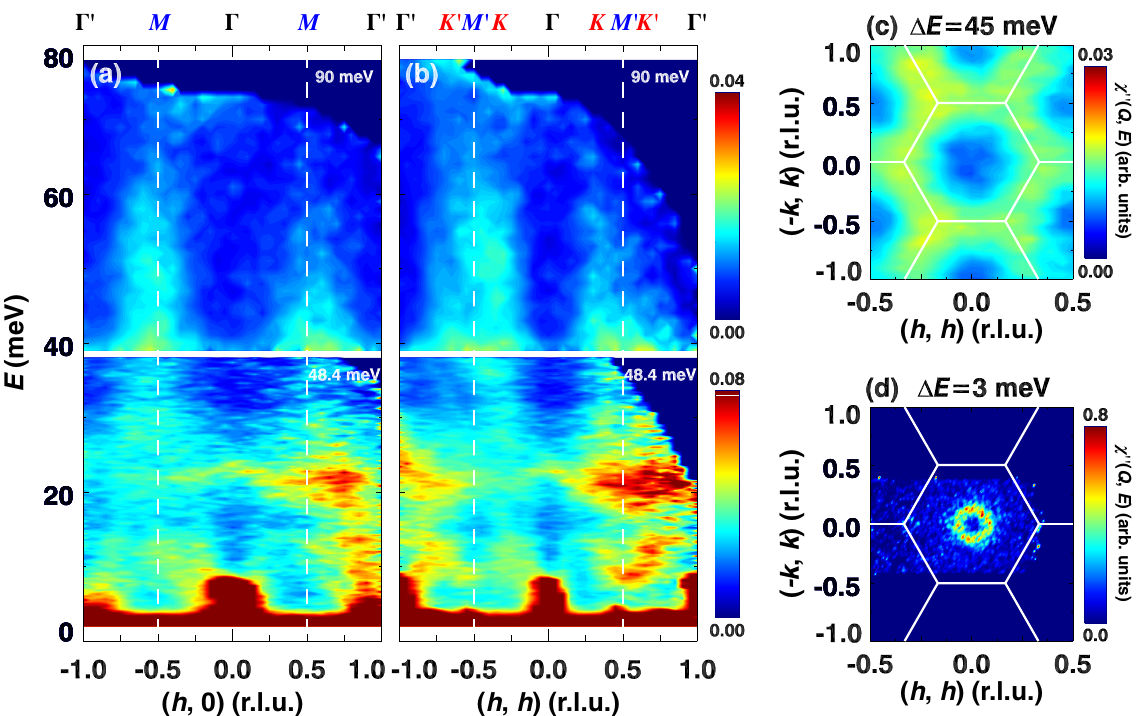
FIG. 2. (a),(b) INS results for the spin excitation spectra at 4 K, along two high-symmetry directions [1, 0] and [1, 1], respectively. The ¼ 48 . 4 meV and integrated over − 0 . 1 ≤ k ≤ 0 . 1 and − 8 ≤ l ≤ 8 r.l.u. The upper lower panels in (a) and (b) were obtained with E i ¼ 90 meV and integrated over − 0 . 1 ≤ k ≤ 0 . 1 and − 10 ≤ l ≤ 10 r.l.u. Vertical dashed lines indicate the panels were obtained with E i ¼ 90 meV. The energy interval was chosen to be M point. (c) Constant- E contour at 45 meV in the ð h; k Þ plane, obtained with E i (cid:2) 5 meV and l was integrated over − 10 ≤ l ≤ 10 r.l.u. (d) Constant- E contour at 3 meVin the ð h; k Þ plane, obtained with E ¼ 8 . 9 meV. i The energy interval is (cid:2) 0 . 1 meV and l was integrated over 1 . 8 ≤ l ≤ 2 . 2 r.l.u. The data had been folded about the l direction for better statistics. Solid lines in (c) and (d) indicate the Brillouin zone